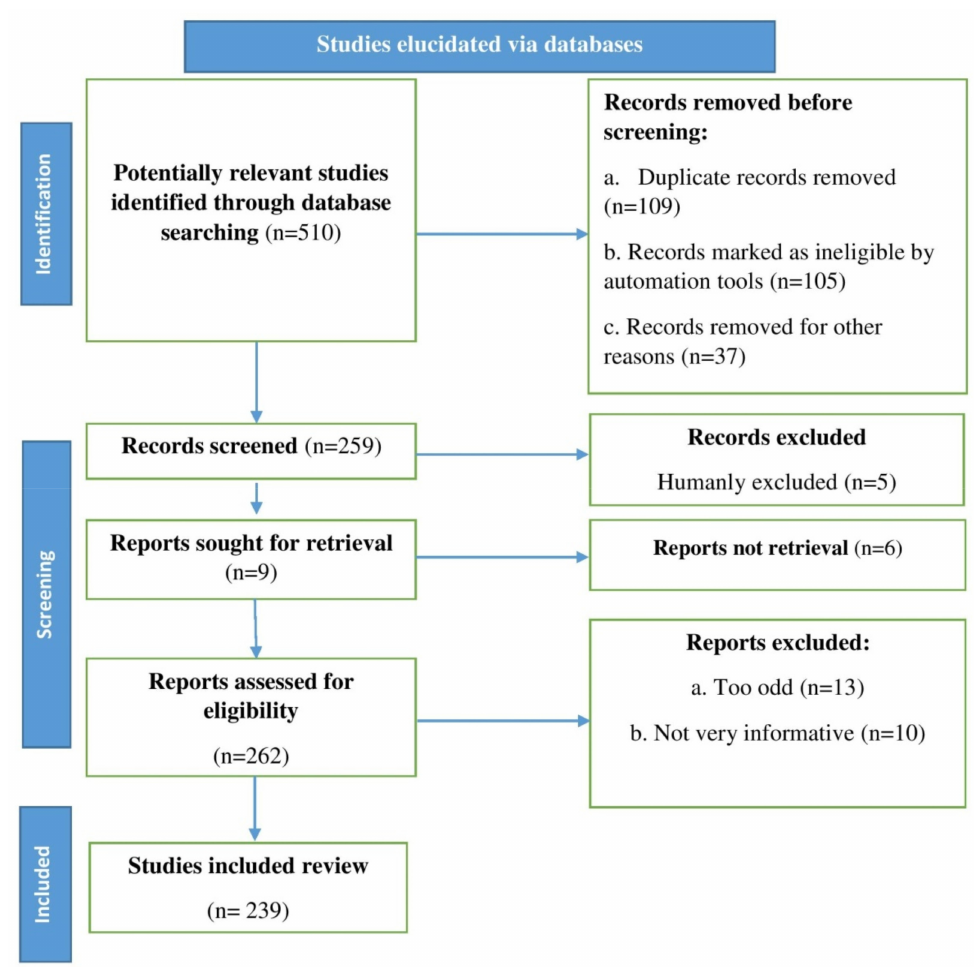
Figure 2. Stages involved in selecting published data for inclusion in the current study are depicted in a flow chart; n = number of literature